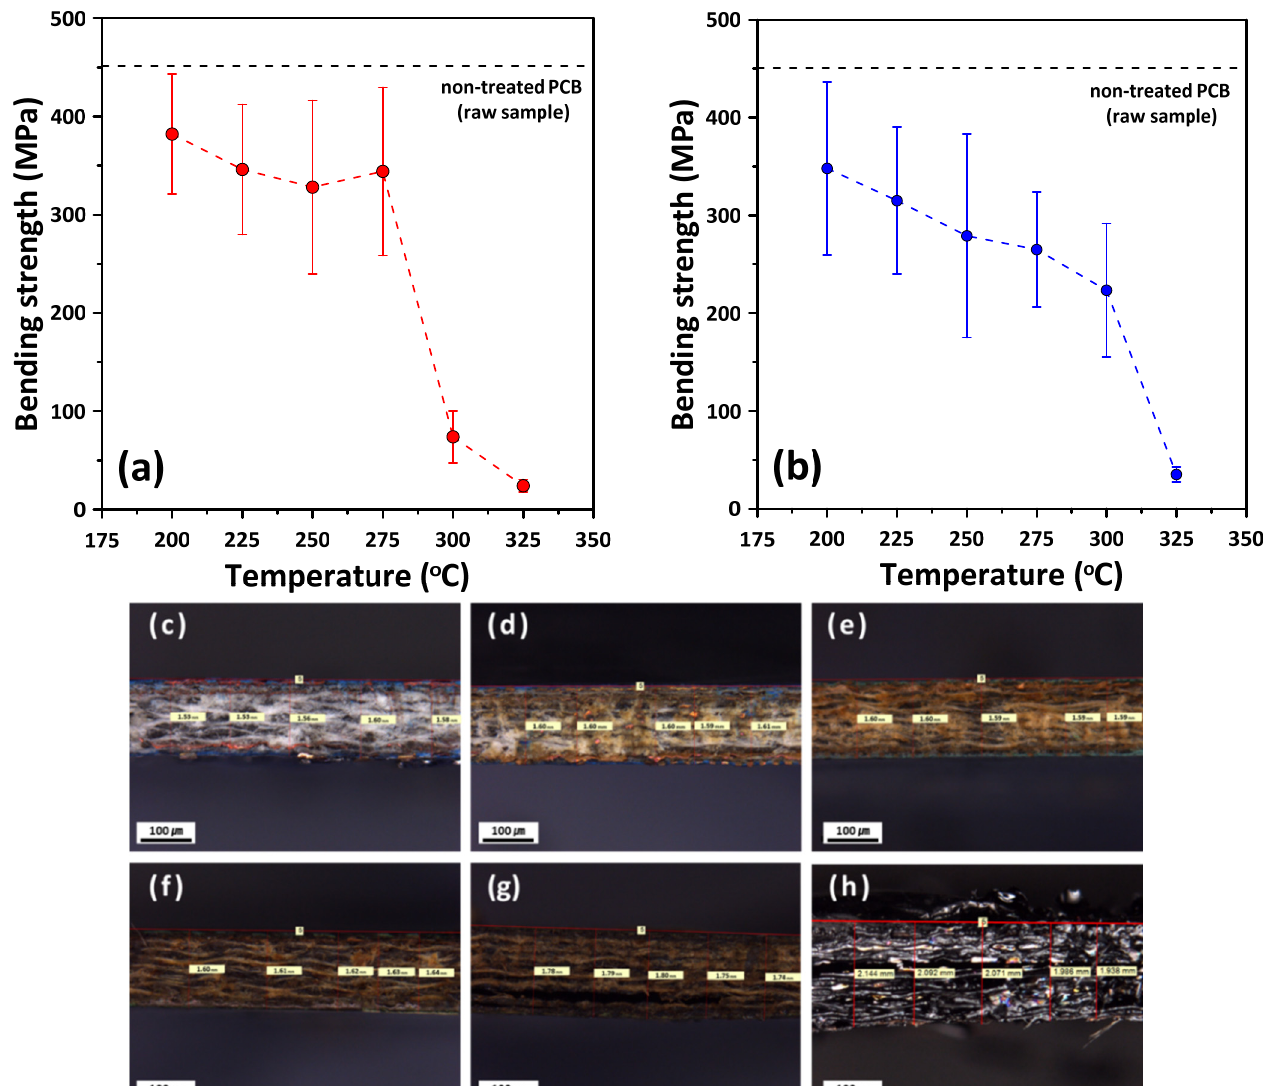
Figure 4. Bending strength results of PCB used in this study according the different temperatures and gas conditions: ( a ) air and ( b ) nitrogen. The black dotted line represents the nontreated PCB sample. The error bar denotes standard deviations. SEM images of the PCB cross-section treated from thermal process: ( c ) 275 °C in air, ( d ) 300 °C in air, ( e ) 325 °C in air, and ( f ) 275 °C in N 2 , ( g ) 300 °C in N 2 , and ( h ) 325 °C in N 2 .